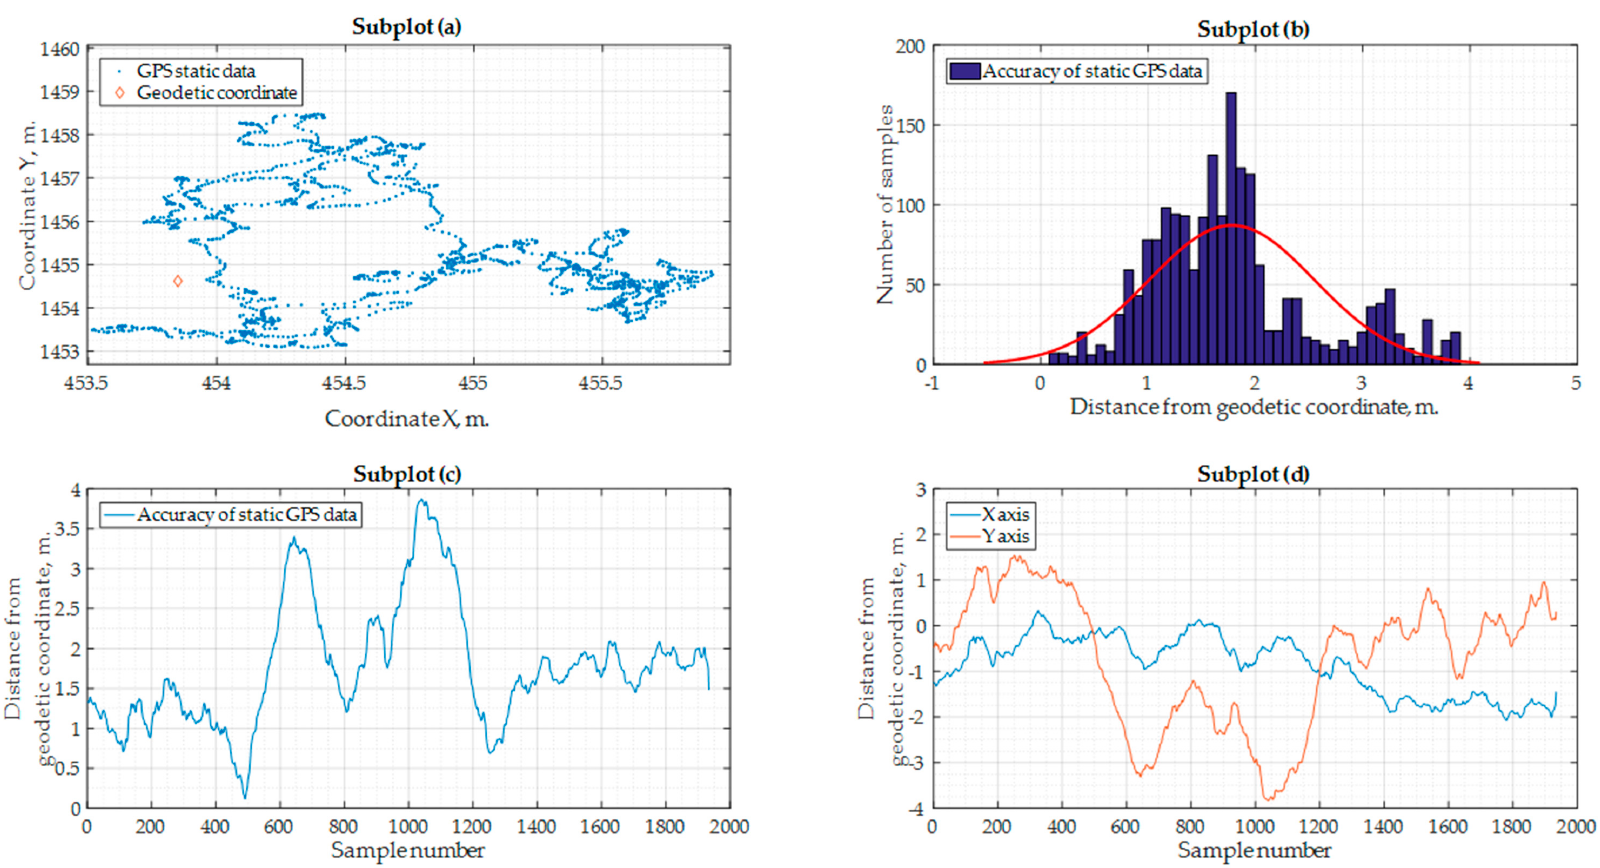
Figure 13. Accuracy of the “Ublox Neo-M8N” GNSS receiver when the data is measured by using a precise geodetic coordinate: ( a ) GNSS receiver measurement drift from the accurately measured geodetic coordinate; ( b ) Gaussian distribution of GNSS samples; ( c ) GNSS receiver measurement error; ( d ) GNSS receiver measurement error in X and Y